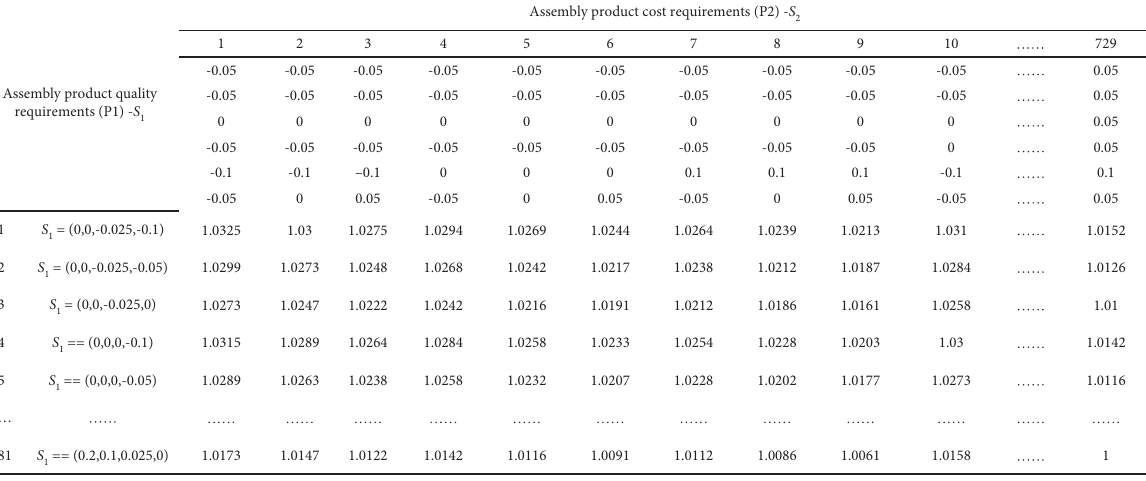
Figure 8: The game utility matrix of alliance {P2}.